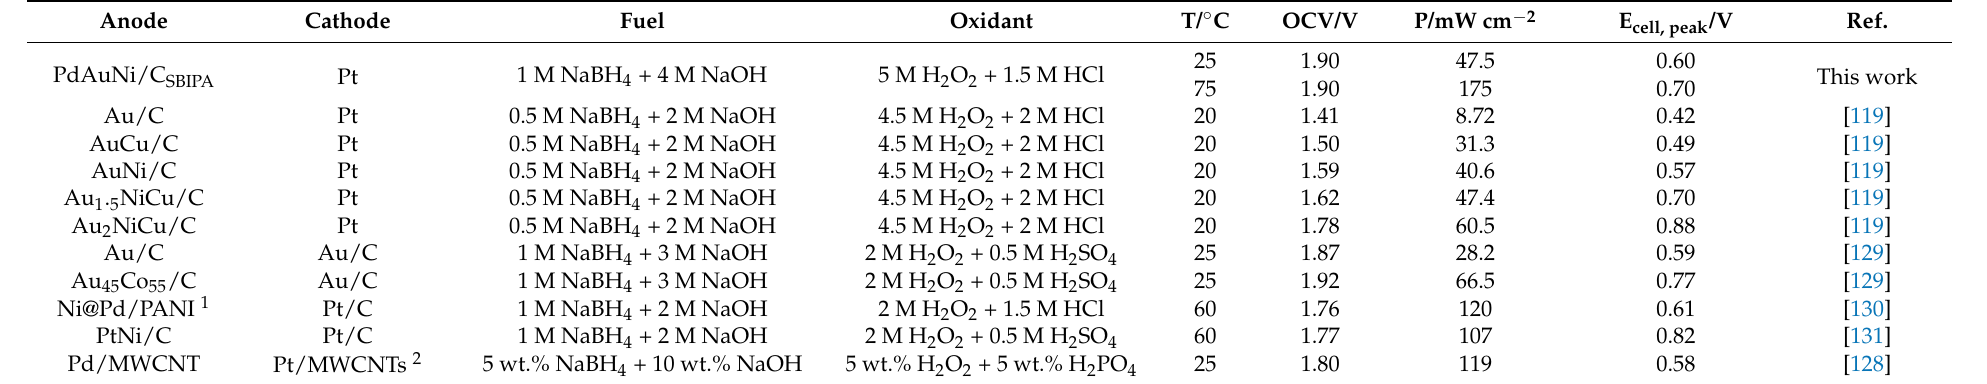
Table 5. Comparison of the DBPFC parameters obtained in this work with those reported in similar studies using Pd, Au, Ni, and their alloys.